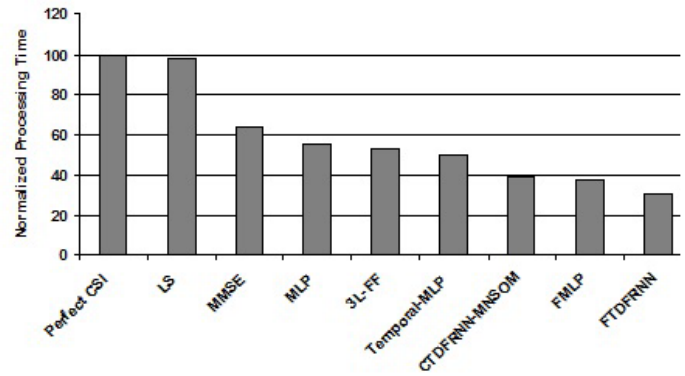
Figure 5. Relative time taken by estimation process carried out with (i) statistical methods (LS, MMSE), (ii) ANN based standard methods (MLP [15], 3L-FF [8], Temporal-MLP [15]), (iii) RNN based approaches (CTDFRNN-MNSOM [16]) and (iv) the proposed architecture (FTDFRNN).